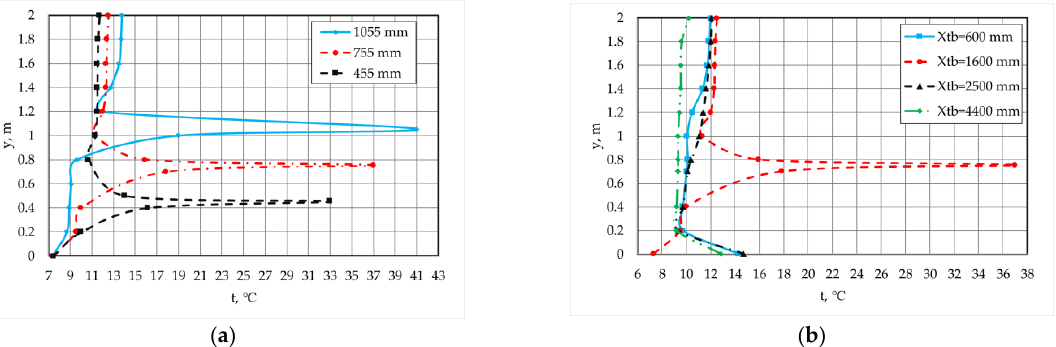
Figure 16. Air temperature distributions in the section under the GIH at the panel location with coordinates: X Tb = 1.6 m and Y Tb = 0.455 m; 0.755 m and 1.055 m ( а ) and at Y Tb = 0.755 m and X Tb = 0.6 m; 1.6 m; 2.5 m and 4.4 m ( b ).